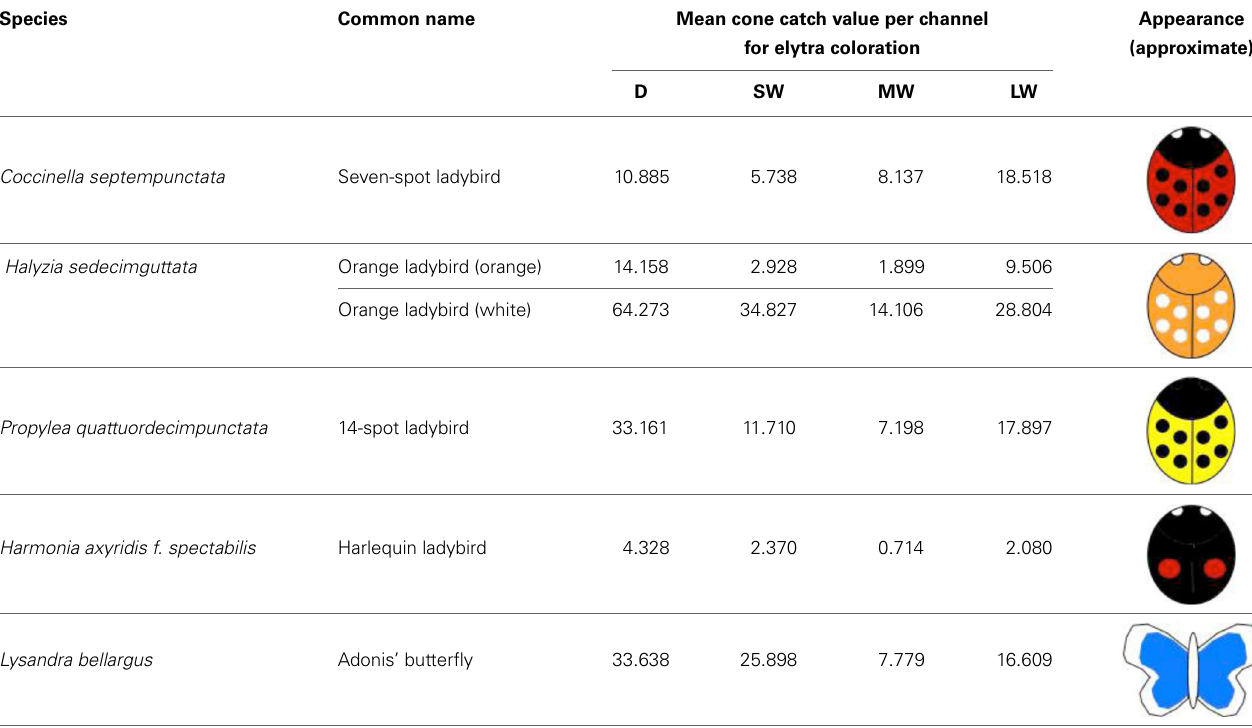
Table 1 | Summary of the species of ladybird beetles collected for this study.